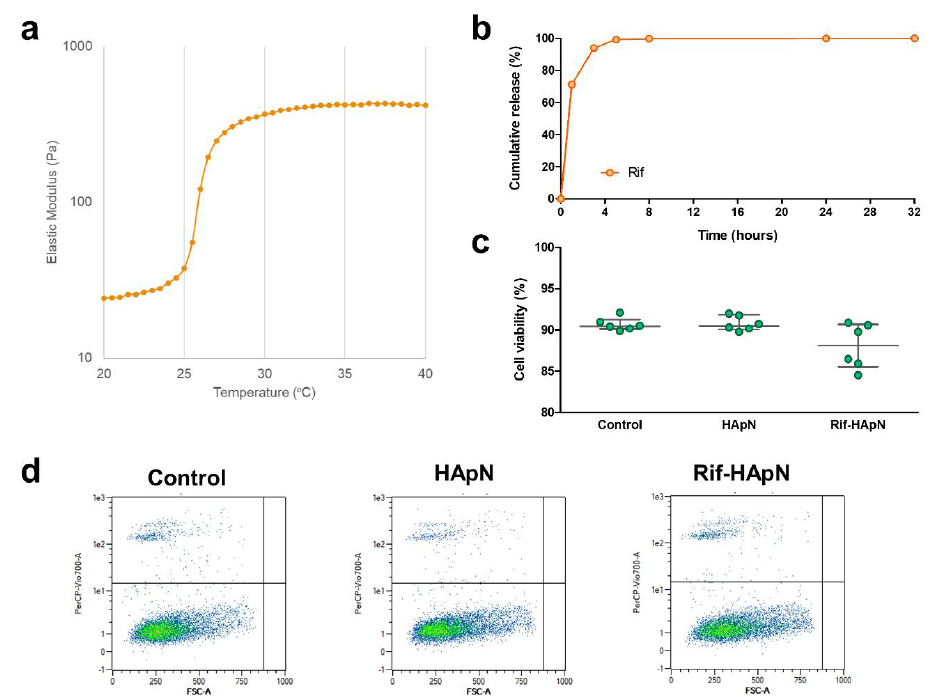
Figure 2. In vitro characterization and cytocompatibility of the hydrogels. ( a ) Rheological assessment of HApN loaded with Rif, showing a lower critical solution temperature (LCST) of 26 °C. ( b ) Cumulative release of rifampicin from 1 cm 2 polypropylene mesh fragments coated with 50 µL of the Rif-HApN hydrogel (n = 3) and incubated at 37 °C in phosphate buffered saline (PBS). ( c ) Rabbit fibroblasts (n = 6) exhibited high viability after 24 h of culture under exposure to the HApN and Rif-HApN hydrogels. For each group, symbols depict the samples tested and grey lines represent the median and interquartile range. ( d ) Flow cytometry scatter dot plots of the different cell cultures evaluated. For each plot, the x-axis represents the forward scatter cell size (FSC-A) and the y-axis represents the propidium iodide fluorescent signal (PerCP-Vio700-A).